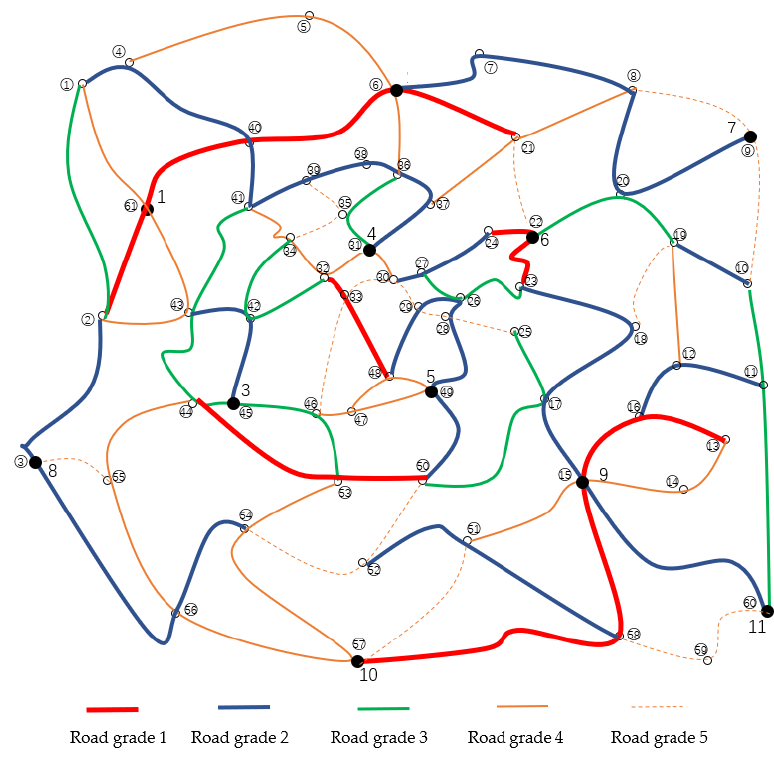
Figure 7. Tra ffi c road grade Figure 7. Traffic road grade diagram.